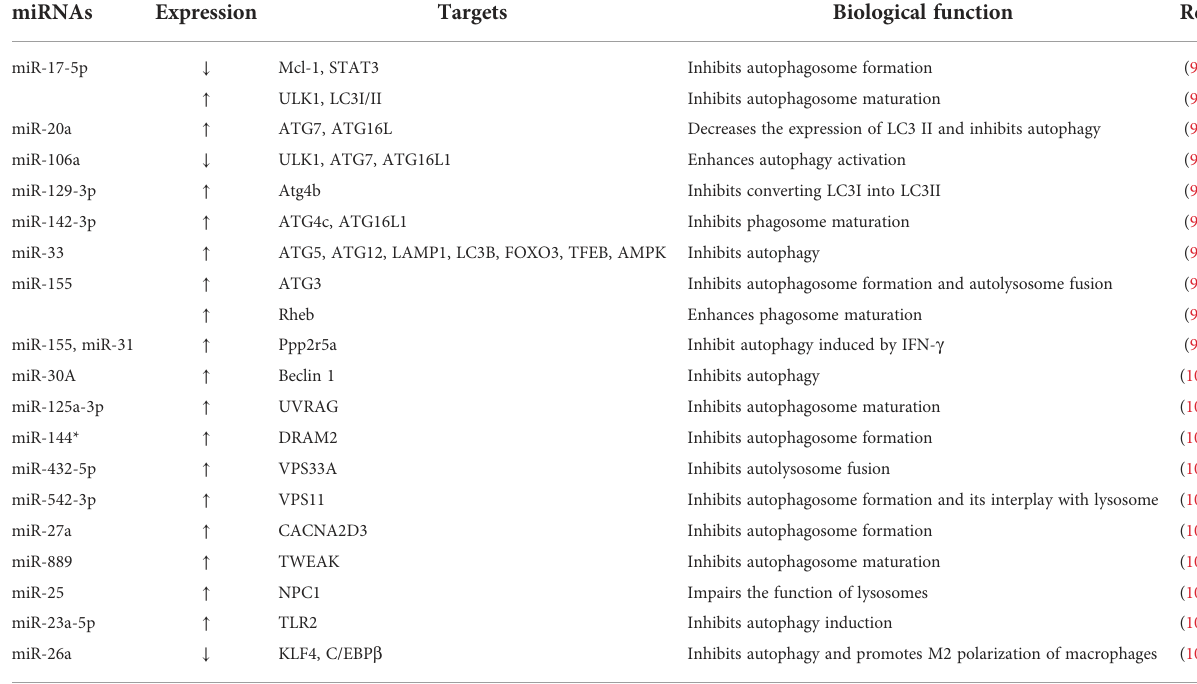
TABLE 2 MicroRNA-regulated autophagy in